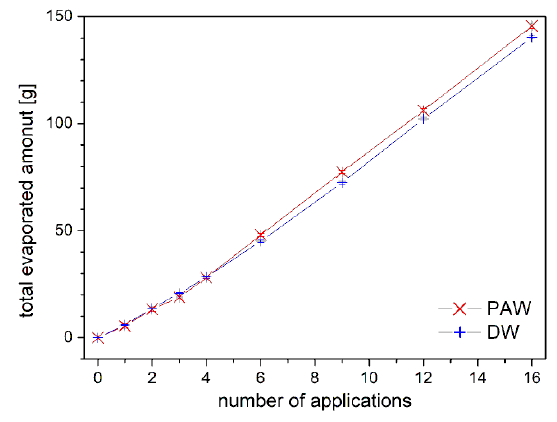
Figure 4. Evaporation of applied water during its applications (PAW—plasma-activated water; DW—distilled water).